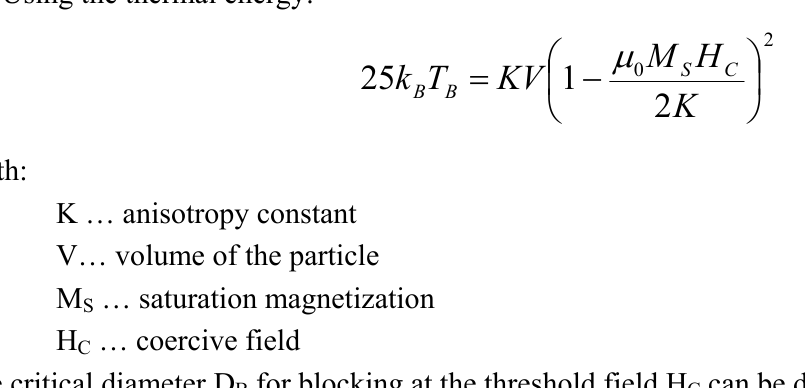
O -nanoparticles 3 4